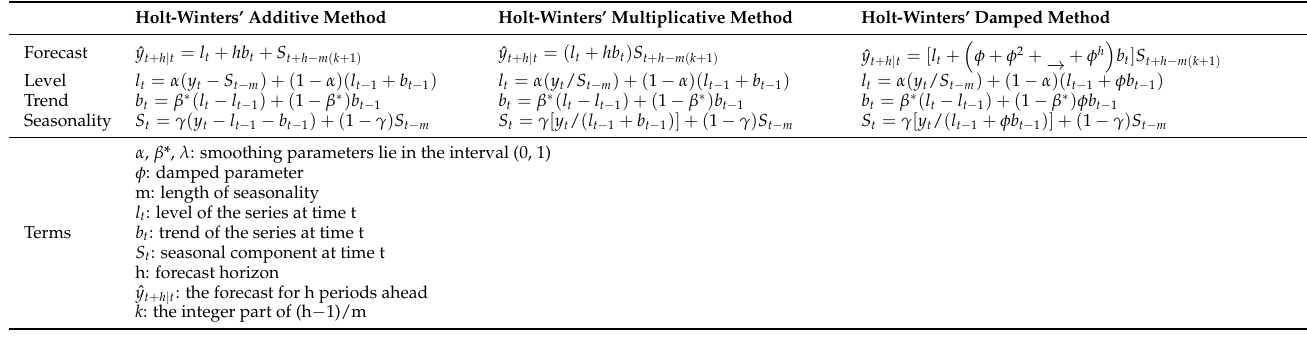
Table 1. Holt-Winters’ additive, multiplicative and damped equations.